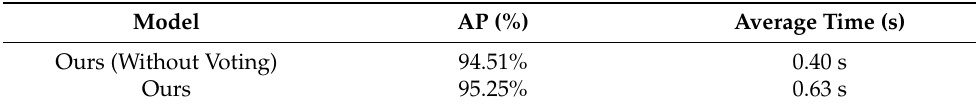
Table 9. Performance of models with different module on Dataset III.